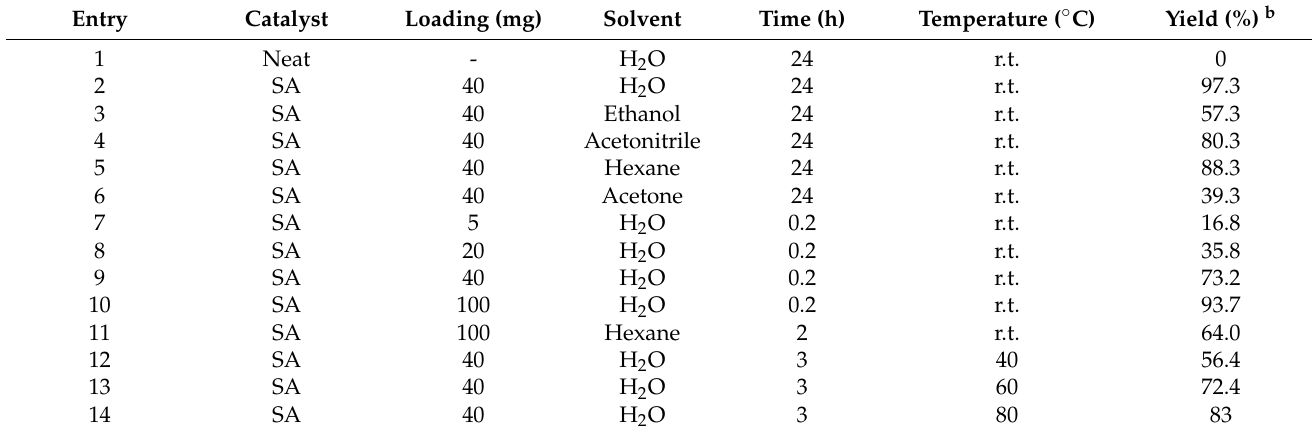
Table 1. Optimization of reaction conditions for the synthesis of 4a catalyzed by naturally occurring SA a